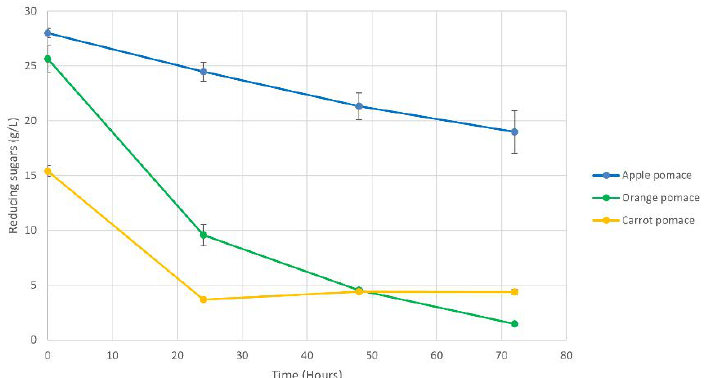
Figure 2. Average soluble reducing sugar concentrations in apple, carrot, and orange pomaces during fermentation with Brettanomyces bruxellensis . Error bars show standard deviation between replicates ( n = 5).